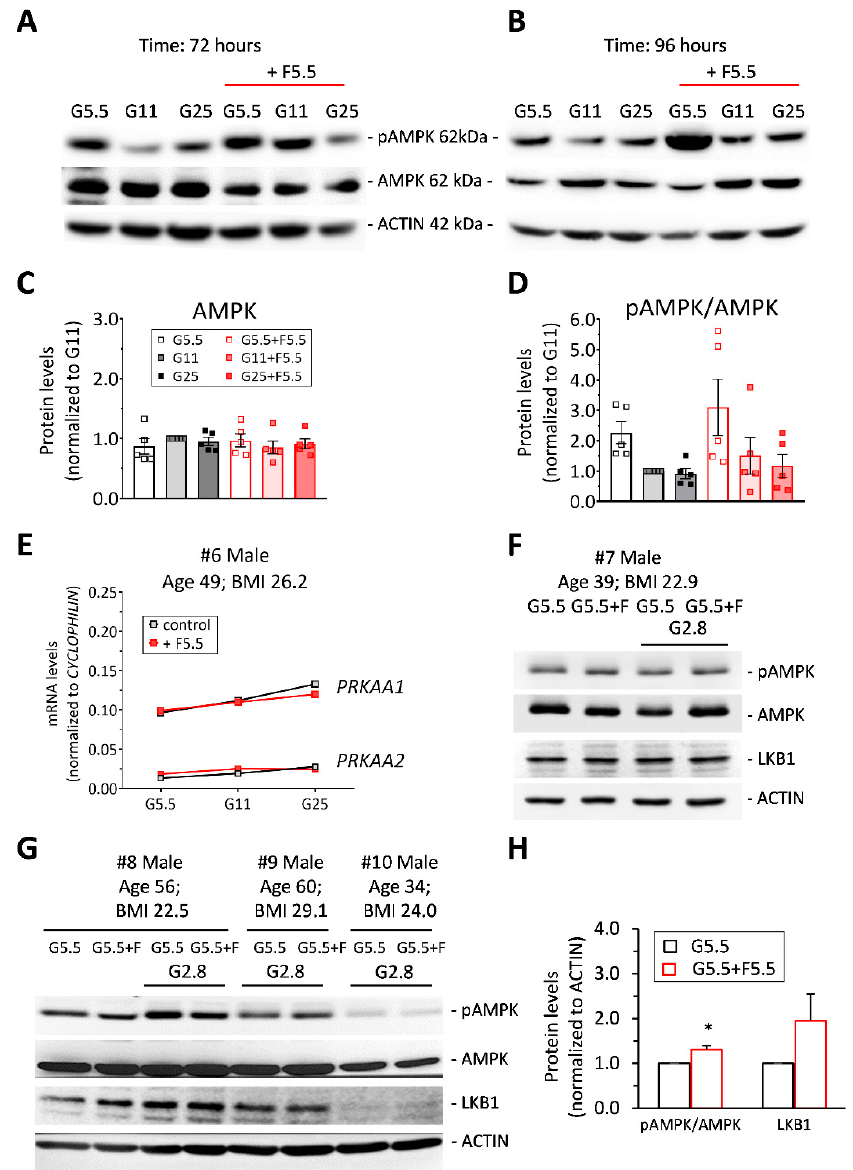
Figure 4. AMPK activation in INS-1E β -cells and in human islets exposed to high glucose and fructose. ( A–D ) INS-1E β -cells were cultured for ( A ) 3 days or for ( B ) 4 days in low (G5.5), standard (G11) and high (G25) glucose supplemented with 5.5 mM fructose (red line). Representative immunoblotting showing levels of pAMPK α , AMPK α (AMPK) and ACTIN in cells right after the culture period. Quantitative analysis of ( C ) AMPK and ( D ) pAMPK / AMPK band densities normalized to ACTIN are shown for 3-day-treated cells ( n = 5). Results are expressed as protein levels normalized to G11 values. ( E-H ) Freshly isolated human islets from six donors were treated for 4 days with 5.5 mM fructose (F) in complete CRML-1066 medium. Culture at 5.5 mM glucose (G5.5) served as a control culture condition. ( E ) Transcript levels of AMPK catalytic subunits α 1 ( PRKAA1 ) and α 2 ( PRKAA2 ) were quantified in a batch of islets from one representative human islet preparation exposed to di ff erent glucose concentrations, normalized to cyclophilin. ( F-G ) Representative immunoblotting showing levels of pAMPK, AMPK, LKB1 and ACTIN from treated islets isolated from four donors right after culture and after 1 h post-culture of glucose starving at 2.8 mM (G2.8). ( H ) Quantitative analysis of pAMPK / AMPK and LKB1 band densities normalized to ACTIN is shown ( n = 6). Results are expressed as protein levels normalized to G5.5 control values. * p < 0.05 G5.5 + F islets versus G5.5